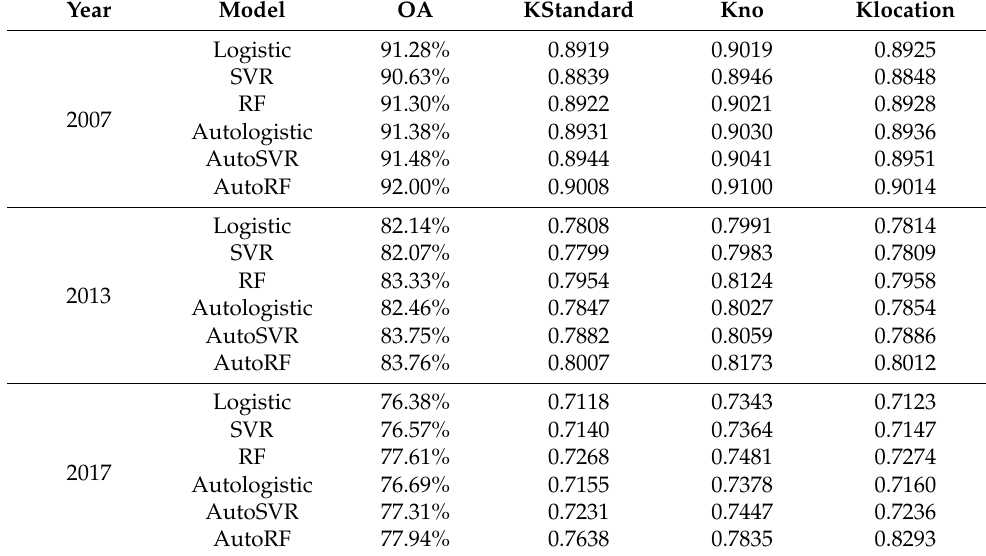
Table 3. OA and Kappa coefficients of different models in 2007, 2013 and 2017.